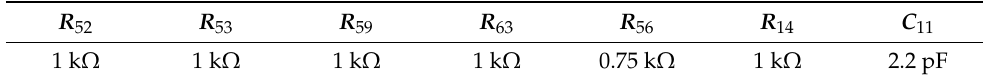
Figure 17. Composite current sensor coupling circuit. Table 3. Electrical parameters of composite current sensor coupling circuit.